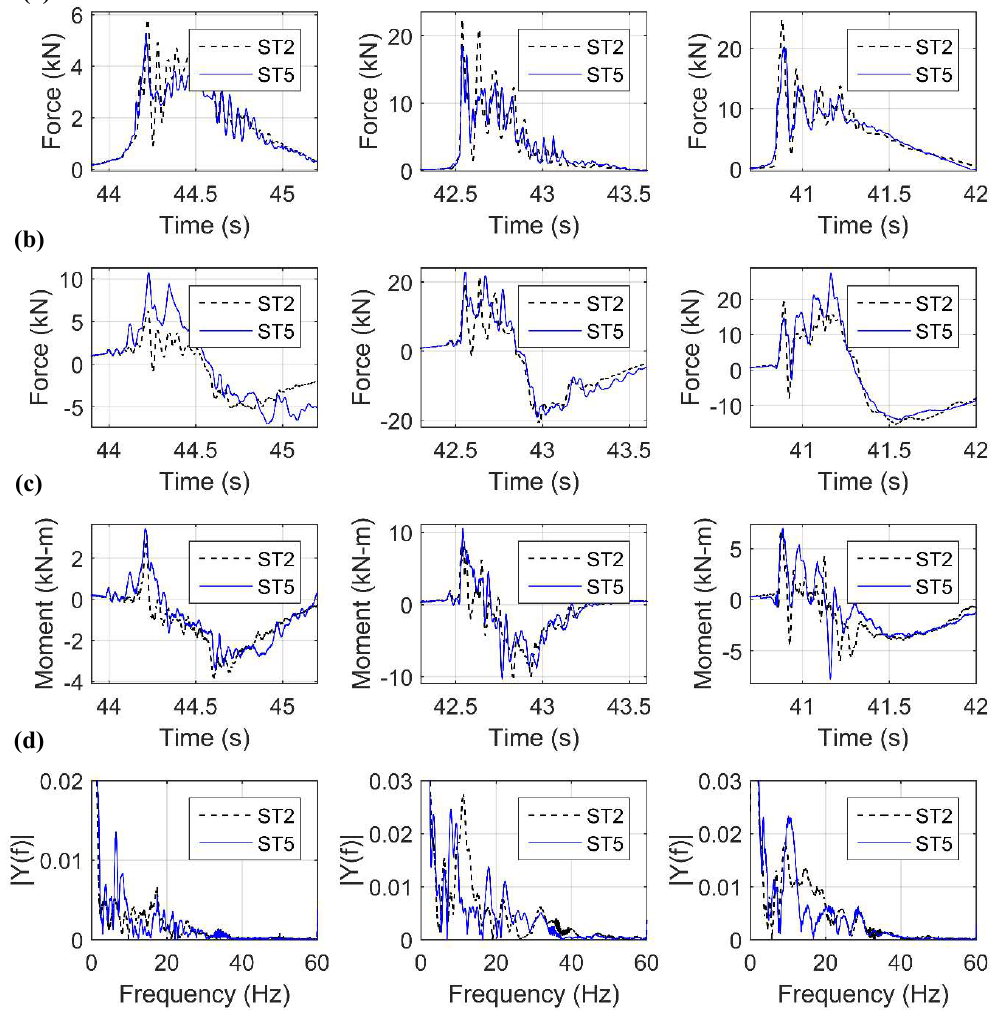
Figure 9. Time histories of ( a ) total horizontal forces, ( b ) total vertical forces, and ( c ) moments, and (d) FFTs of the total vertical forces, for three waves with H = 0.42 m (l eft ), H = 0.65 ( middle ), and H = 0.90 m ( right ), and two deck types (FFT = Fast Fourier Transform)